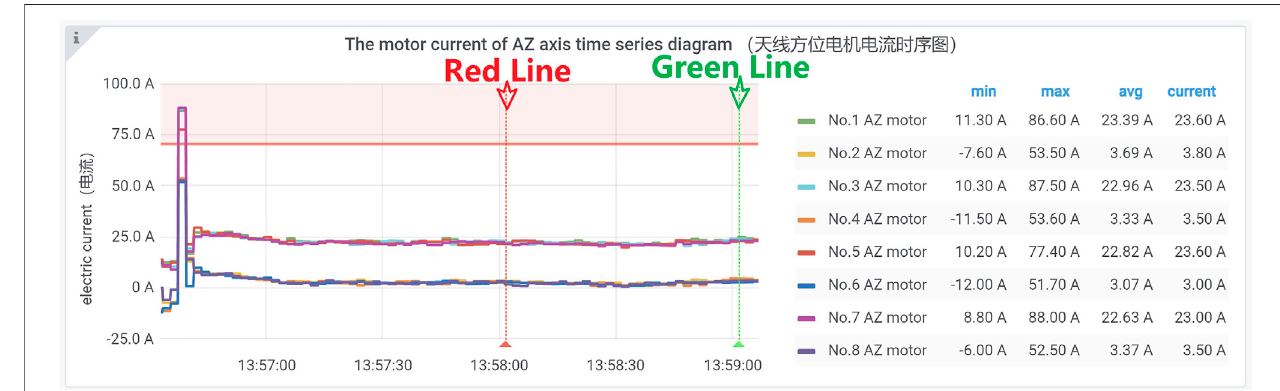
FIGURE 4 | This is a sample timing diagram for an antenna AZ motor current alarm. In the fi gure, the motor current curve has broken through the red alarm area above, and then Grafana will mark 13:58:00 with a red line, which shows that there was a voltage anomaly within 2 minutes. The green line at 13:59:00 shows that the abnormality did not appear after the time point marked by the red